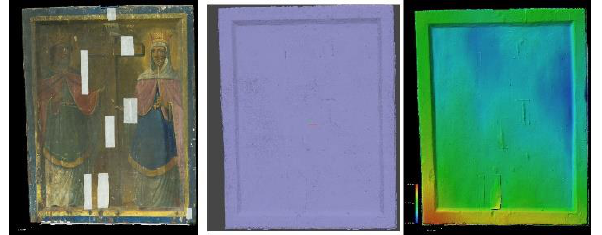
Figure 5. Left: orthophoto mosaic. Center: Mesh. Right: DEM The 3D digital reconstruction was exported to OBJ format file